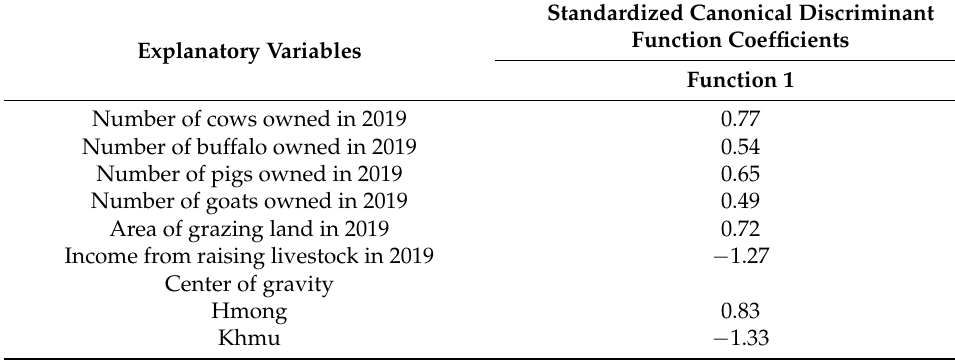
Table 4. Livestock-related explanatory variables with standardized canonical discriminant func- tion coefficients.